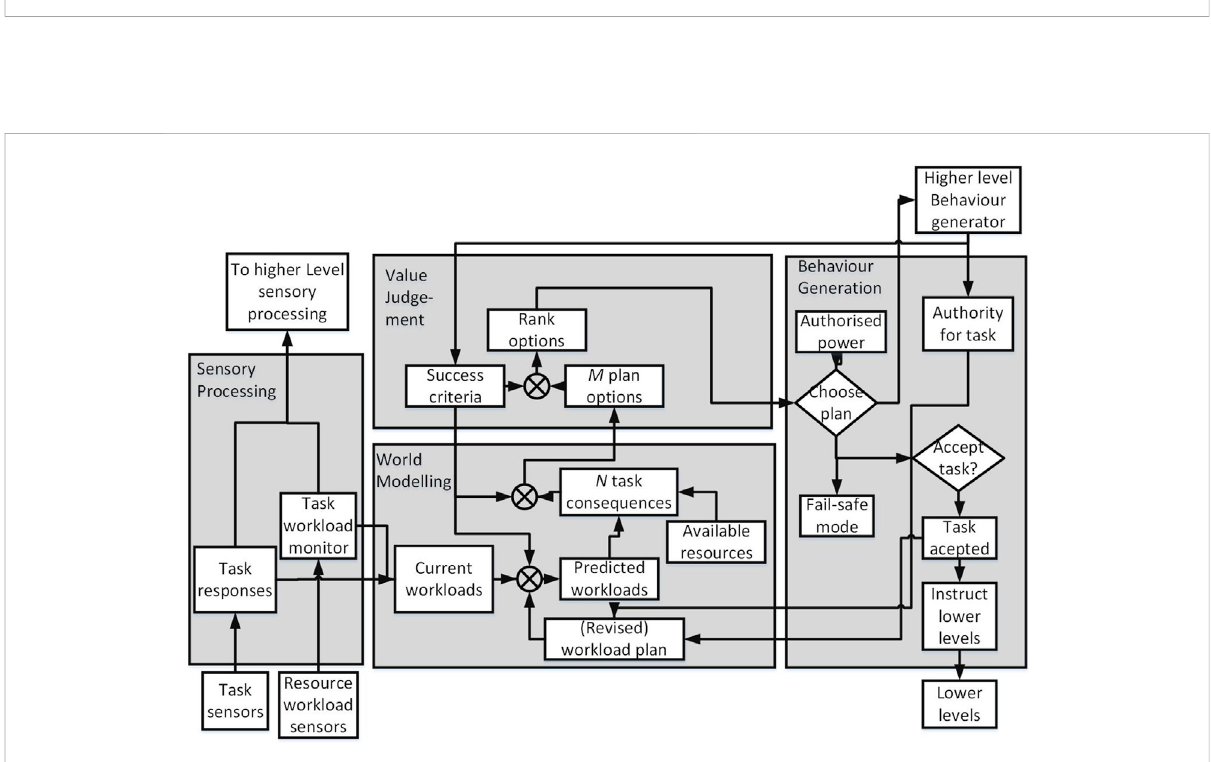
FIGURE 5 Information fl ows within and between the functions in a node. Each function is a shaded box. Information processing is in the white boxes and comparisons in the